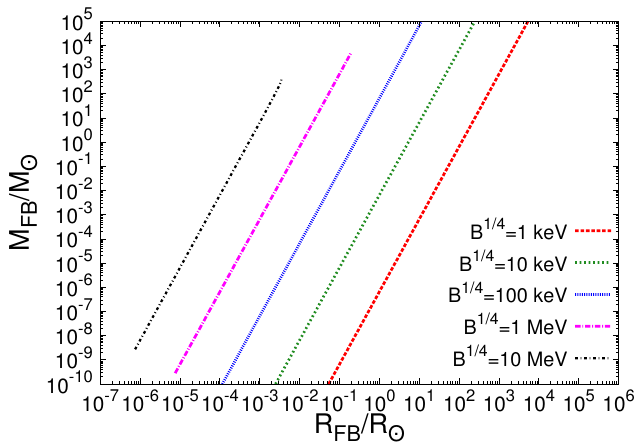
Figure 3 . Correlation between M FB and R FB obtained by varying P | R =0 and solving the Tolman- Oppenheimer-Volkoff equation for several values of B 1 / 4